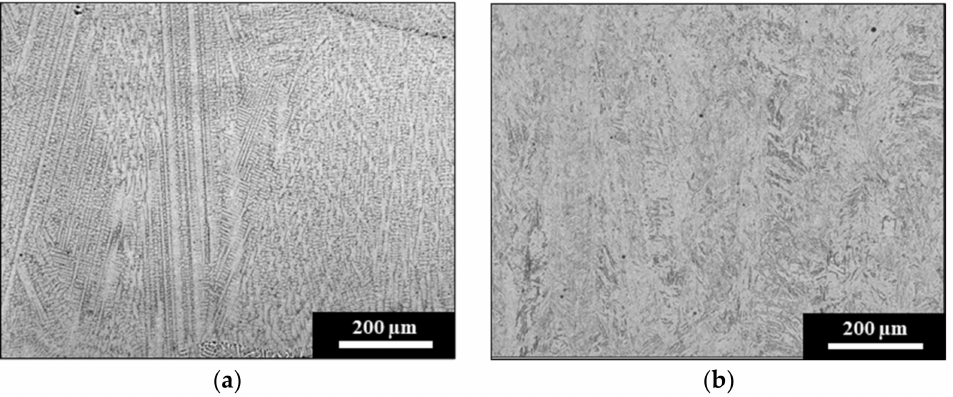
Figure 4. Laser cladding microstructure on light rail substrates from ( a ) Stellite 6 depositions contain-